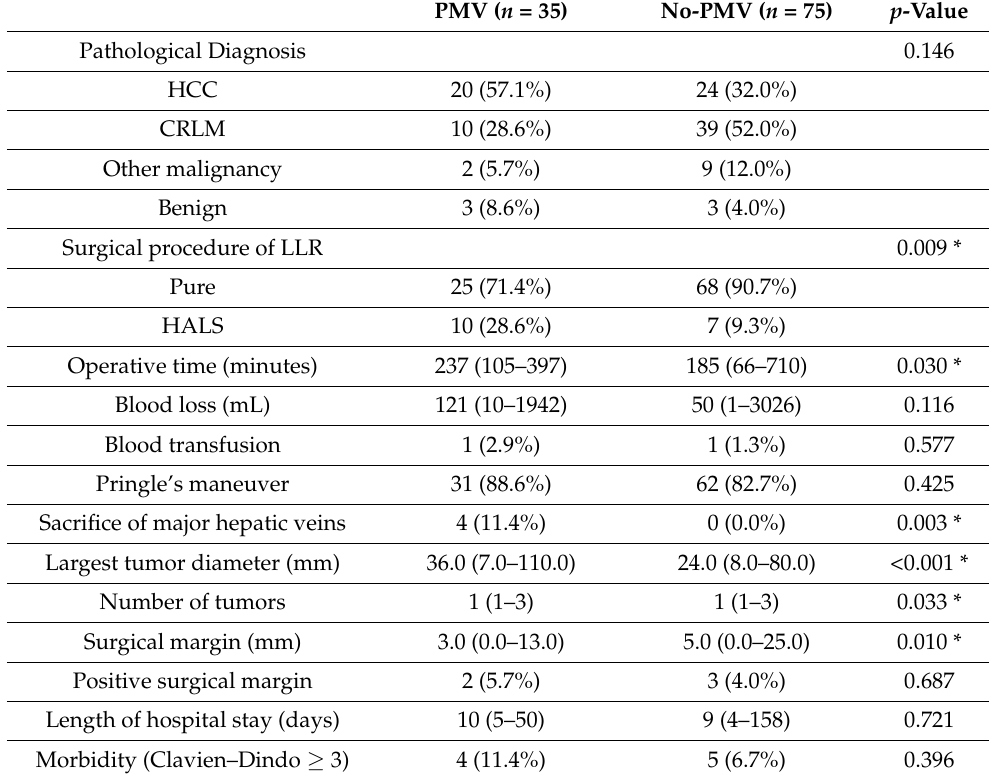
Table 4. Surgical outcomes of PMV and no-PMV